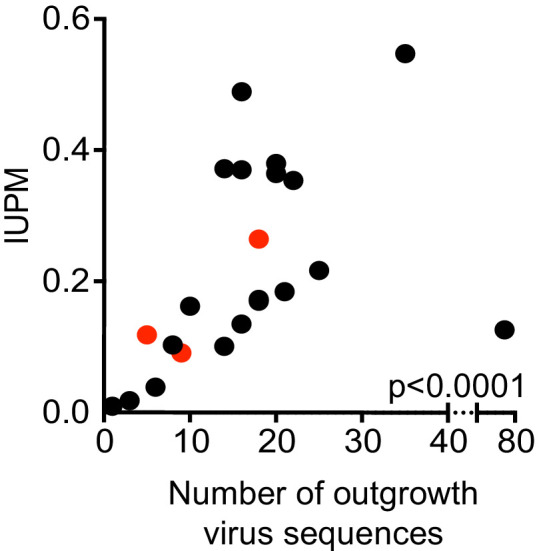
Size of the replication-competent reservoir as measured by infectious units per million (IUPM) against the number of sequences obtained by PacBio sequencing (r = 0.755, p<0.0001, Spearman Rank, n = 24 pairs).Red dots are participants treated during acute HIV infection.